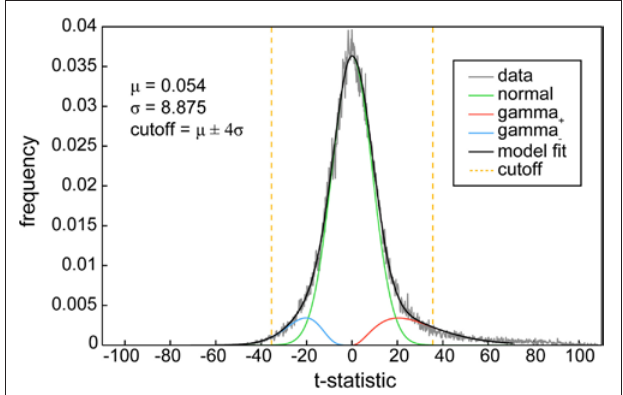
Figure A1 | A typical example of the normal-gamma-gamma (Nggs) model, fit to the distribution of t -statistics for iC 38. The distribution (gray) is relatively well described by a mixture of a normal (green), positive gamma (red), and negative gamma (blue). The full model fit is shown in black, and cutoffs ( m ± 4 s ) are determined from the estimated mean ( m ) and SD ( s ) of the normal. Thresholded SMs include only voxels with positive t -statistics: t > m + 4 s